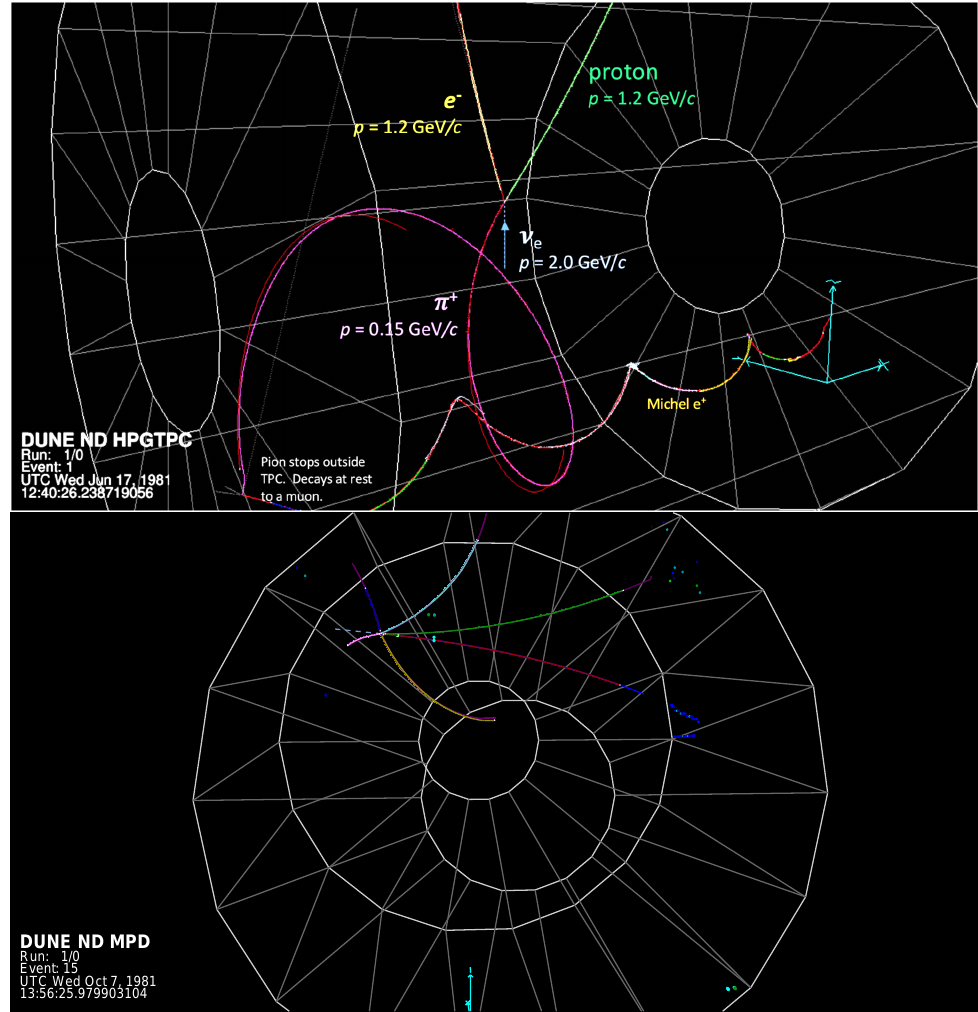
Figure 59. ( Top ) Track-reconstructed ν e CC event in the HPgTPC, simulated and reconstructed with GArSoft. The annotations are from MC truth. ( Bottom ) Track-reconstructed ν µ CC event with five